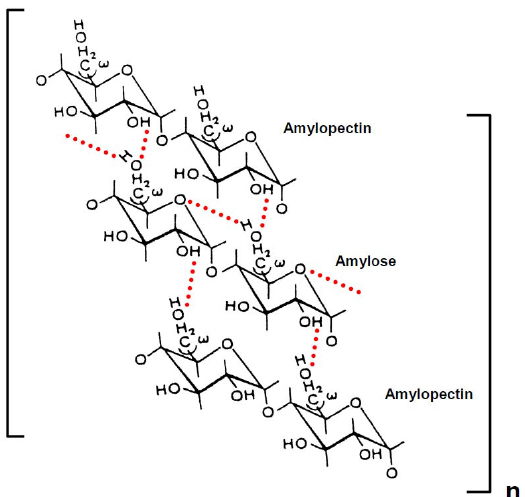
Scheme 3. Possible mode of retrogradation mechanism of rice, potato and wheat starch in aqueous solution. Dotted lines represent hydrogen bonding. The chains of amylopectin are short side-chains (A or